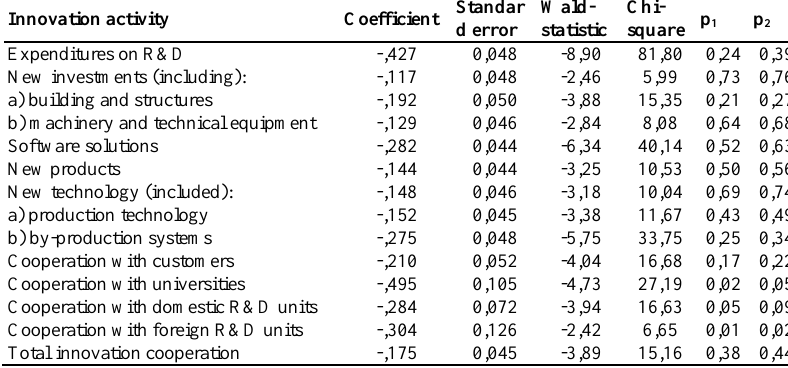
Table 2. Coefficient value by independent variable „regional range”, in probit models describing innovation activity in the polish manufacturing